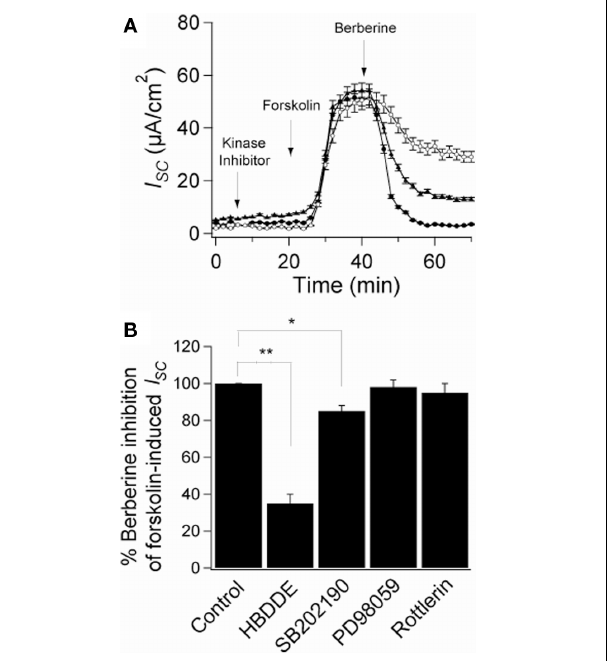
FIGURE 6 | Role of protein kinases on the antisecretory effect of berberine. (A) Short-circuit current recordings inT84 cell monolayers of the effect of protein kinases inhibitors on the antisecretory effect of berberine (300 μ M). Cells were pre-incubated for 15min with HBDDE 100 μ M ( (cid:3) ), SB202190 10 μ M ( ◦ ), or vehicle DMSO 0.05% ( • ). (B) Mean ± SEM ( n = 6) change in total I SC caused by preincubation with several kinase inhibitors on the antisecretory effect of berberine on forskolin-stimulated I SC .Values are mean ± SEM, n = 6, * P < 0.05, ** P < 0.01 compared to